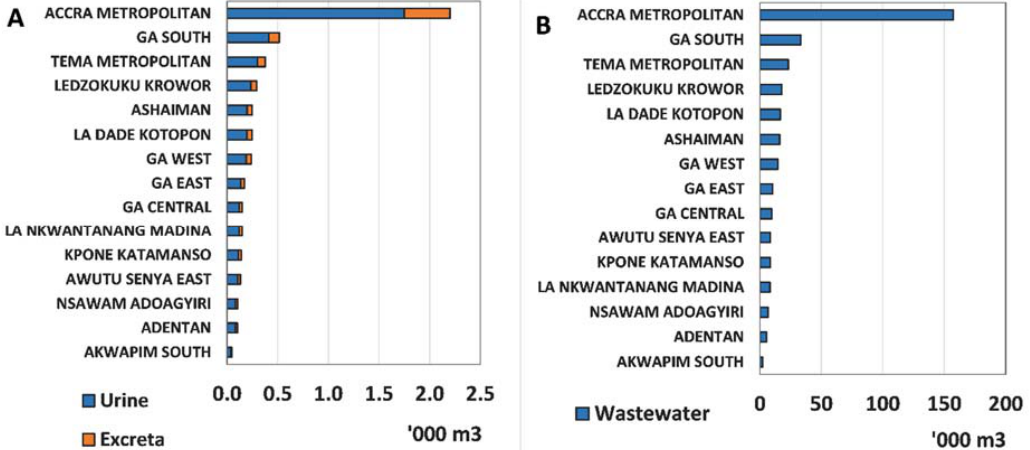
Figure 8. Total wastewater and human excreta (feces and urine) generation estimates in GAMA per district for 2010 by sink. ( A ) Feces and urine generated per district of GAMA in thousands of m 3 . ( B ) Wastewater generated per district of GAMA in thousands of m 3 .